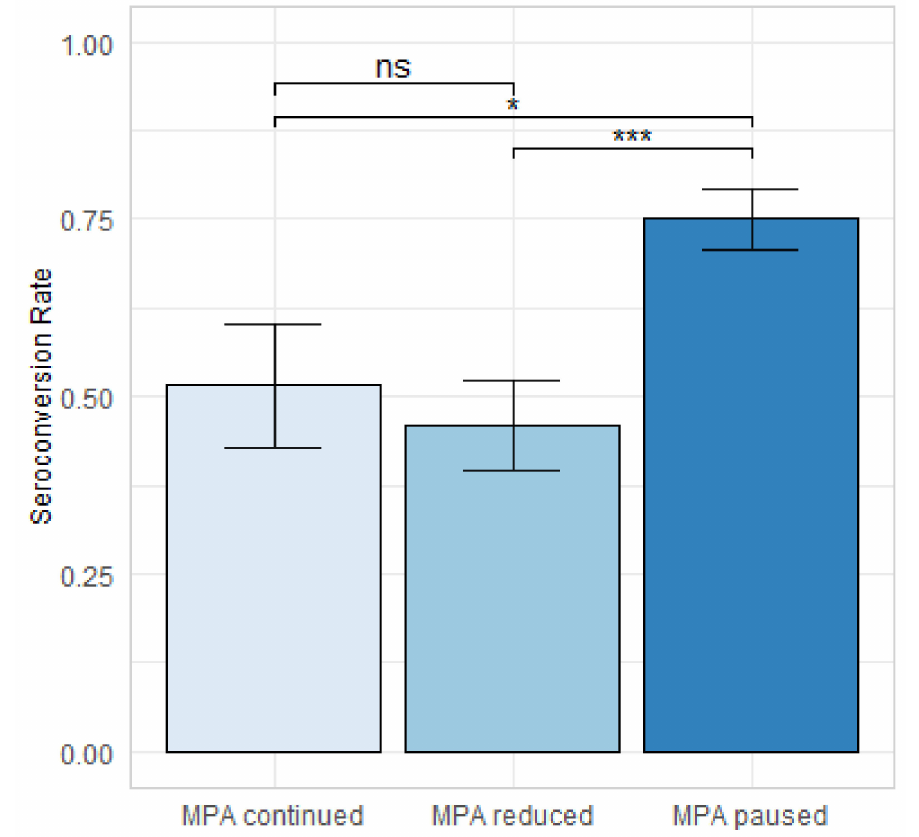
Figure 3. Serological response rates after four doses of SARS-CoV-2 vaccines in kidney transplant recipients with steady MPA dose ( n = 33), reduced MPA dose ( n = 63), and paused MPA ( n = 103). * adjusted p < 0.05, *** adjusted p <